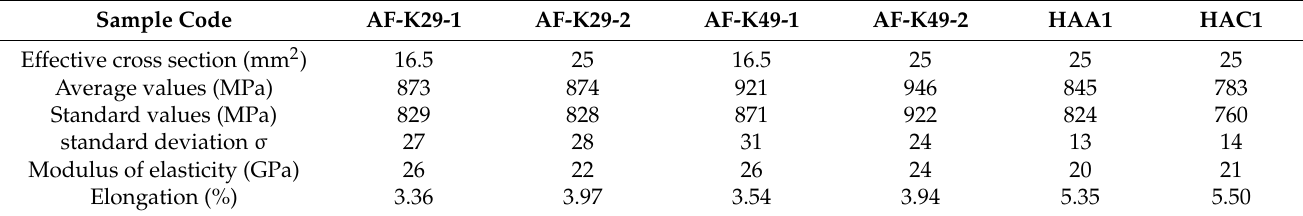
Table 4. Elastic modulus and elongation of